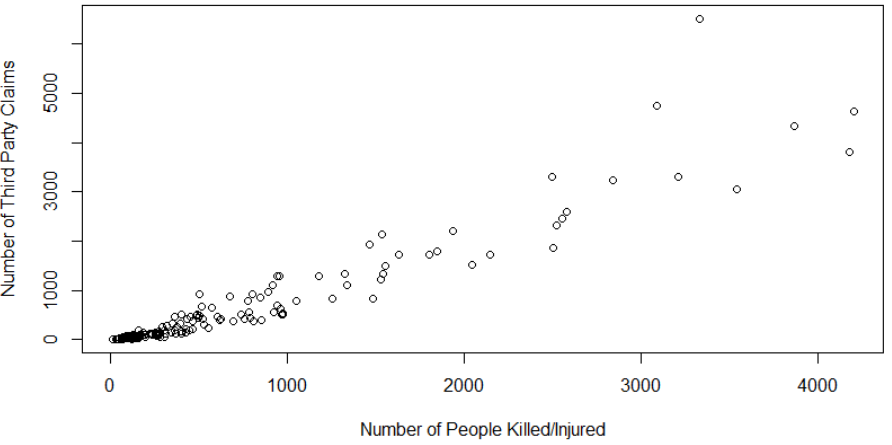
Figure 7. Scatterplot of the Model 4